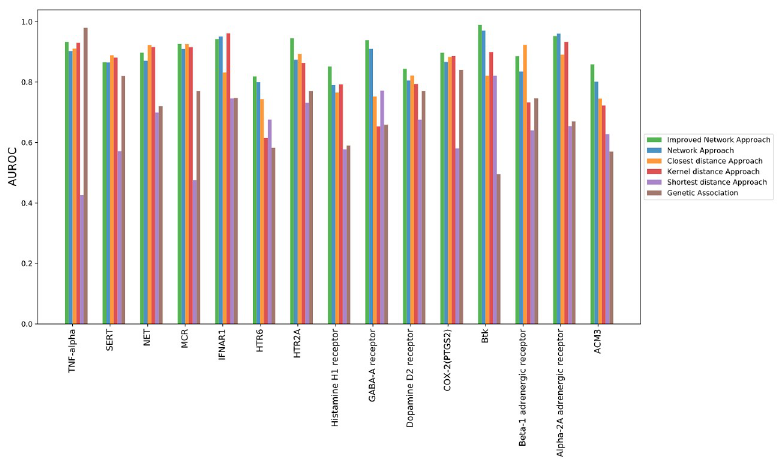
Fig 2. AUROC performance of network algorithm, improved network algorithm, genetic association and random genes.